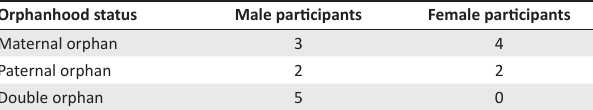
TABLE 1: Participants’ demographics in the